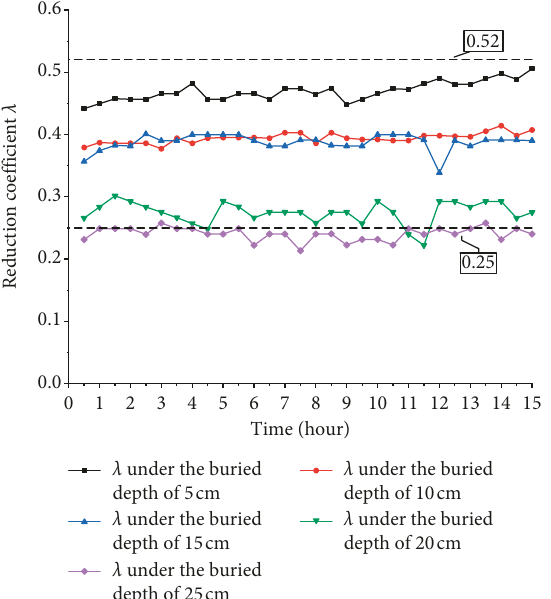
Figure 10: Variation of reduction coefficient λ with the action time of groundwater pressure under different buried depths.